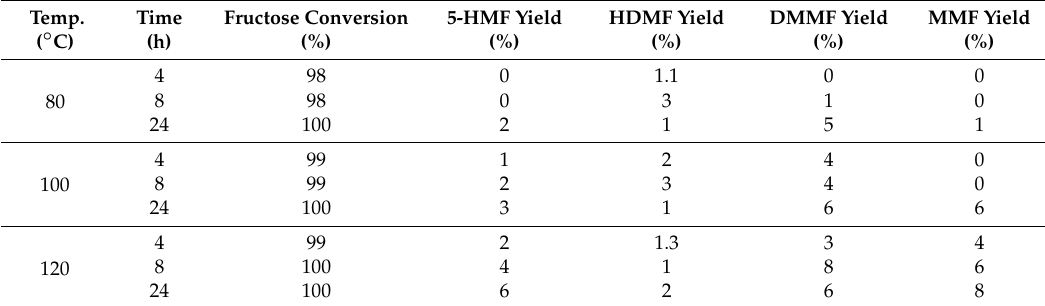
Table 1. Results of the reaction of fructose and methanol in the presence of SiO 2 -HNO 3 . a